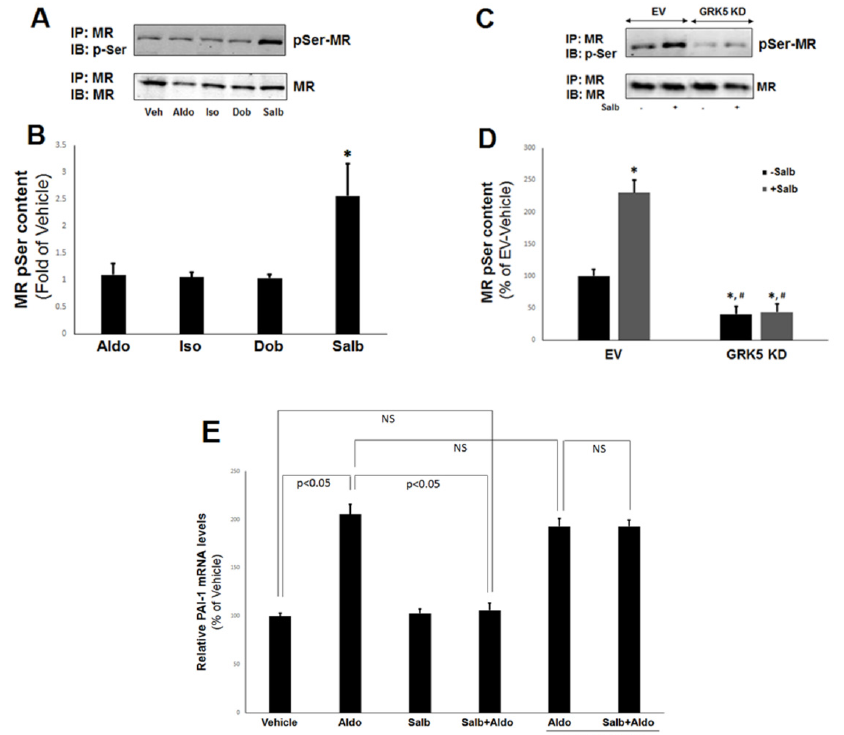
Figure 5. β 2 AR stimulates the GRK5-dependent phosphorylation and inhibition of the cardiac MR. ( A , B ) Immunoblotting for phosphoserine content of the MR in response to 15-min-long treatments with 100 nM Aldo, 10 µ M isoproterenol (Iso), 1 µ M dobutamine (Dob), or 10 µ M salbutamol (Salb) in native ARVM lysates. Representative blots are shown in ( A ), and the relative densitometric quantitation of five independent experiments done in duplicate is shown in ( B ). * p < 0.05, vs. any other treatment; n = 5. ( C , D ) Immunoblotting for phosphoserine content of the MR in response to 10 µ M salbutamol (Salb) for 15 min or vehicle (DMSO) in ARVMs transfected with a GRK5 kinase-dead dominant negative mutant (GRK5 KD) lentivirus or control, mock (empty vector, EV) lentivirus. Representative blots are shown in ( C ), and the relative densitometric quantitation of six independent experiments done in duplicate is shown in ( D ). * p < 0.05, vs. EV / − Salb; # , p < 0.05, vs. EV /+ Salb; n = 6. IP: immunoprecipitation; IB: Immunoblotting. ( E ) mRNA levels of plasminogen activator inhibitor (PAI)-1 in response to a 2-hr-long treatment of 100 nM Aldo alone or in the presence of 10 µ M salbutamol (Salb + Aldo) in ARVMs. Lenti-GRK5 KD: Cells transfected with a GRK5 kinase-dead mutant lentivirus. 18S rRNA levels were used for normalization of the results. NS: Not significant at p = 0.05; one-way ANOVA with Bonferroni test; n = 6 independent experiments done in duplicate samples /